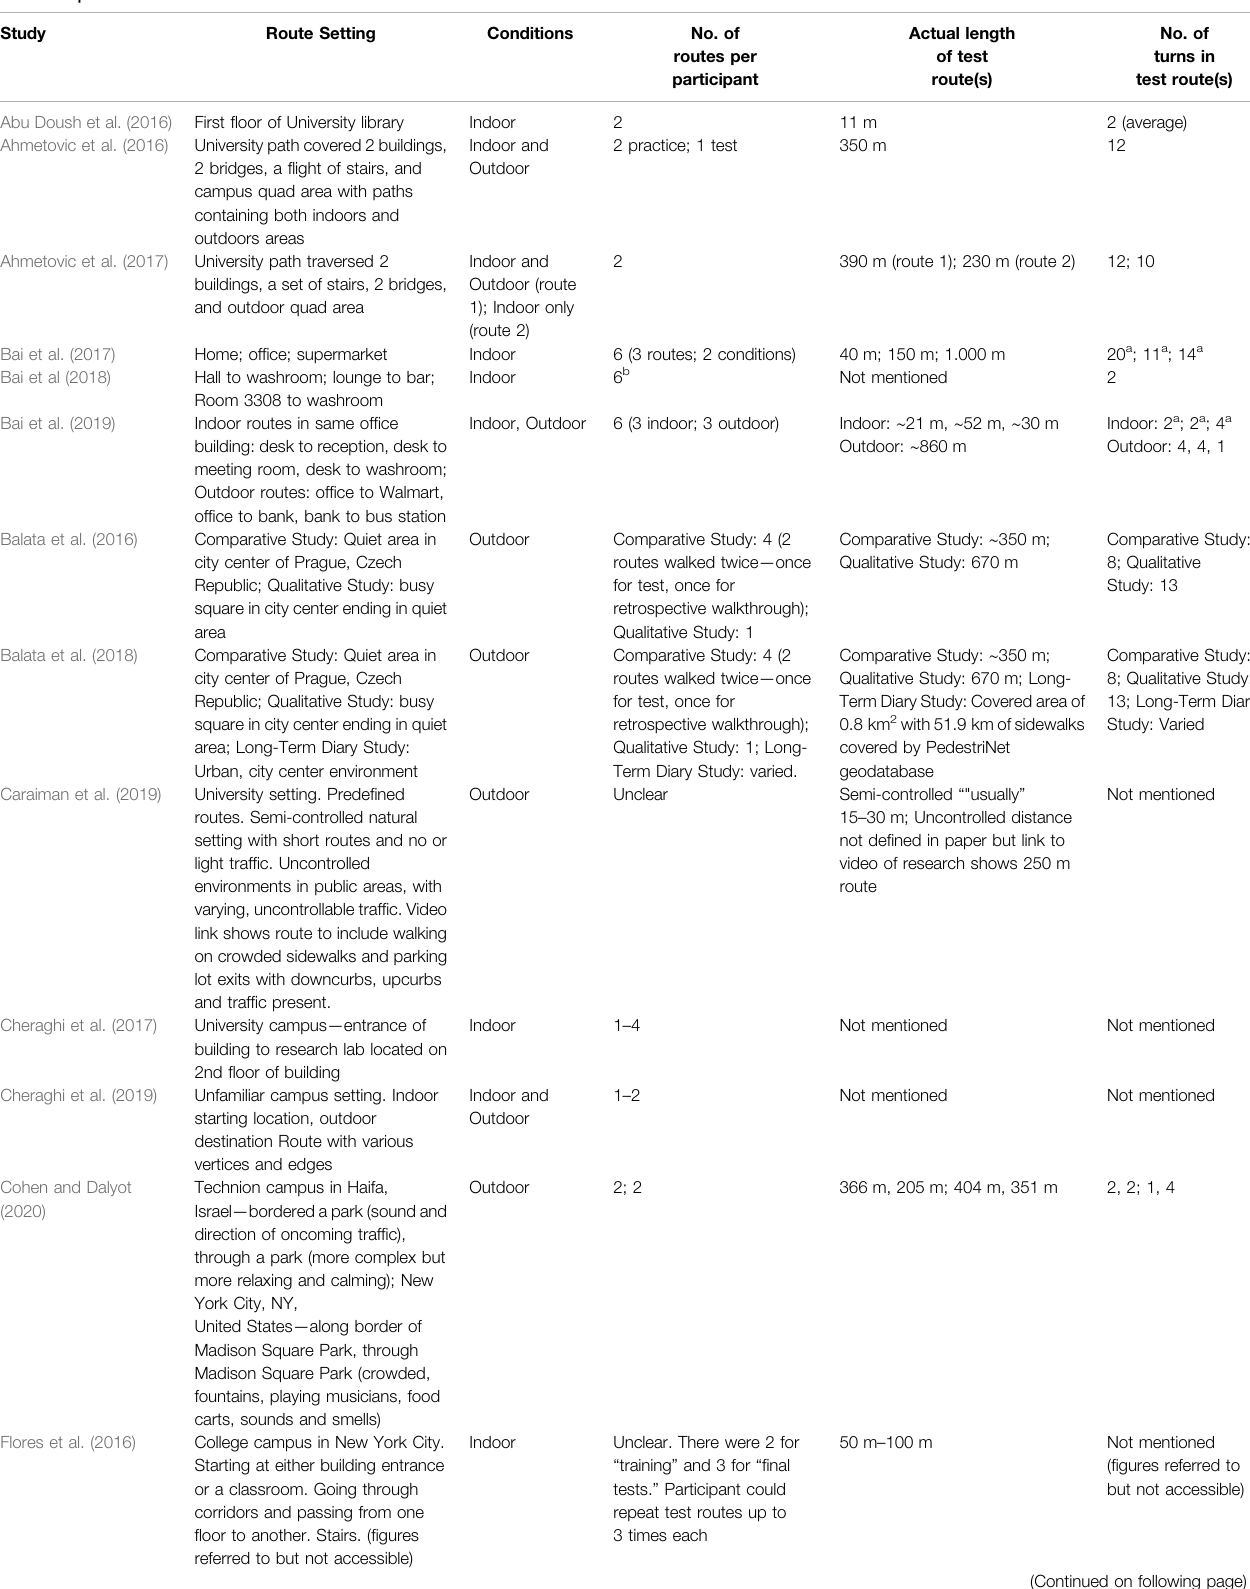
TABLE 3 | Real-world